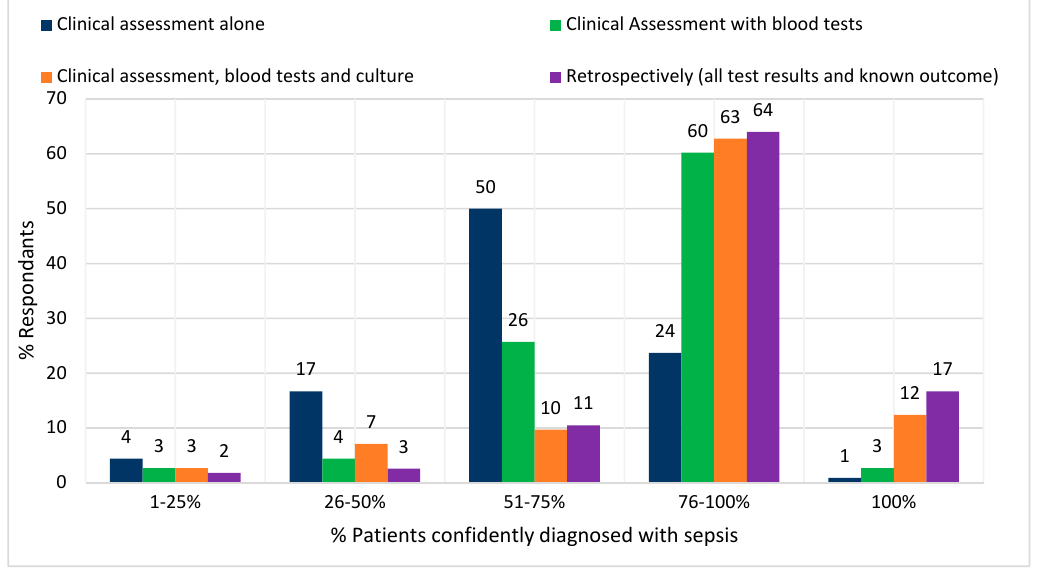
Figure 3. Percentage of consultants estimating what percentage of sepsis patients could be confidently identified using temporal sequence with increasing information.